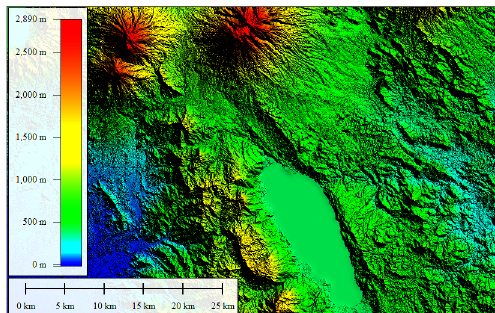
Figure 13. DTM master